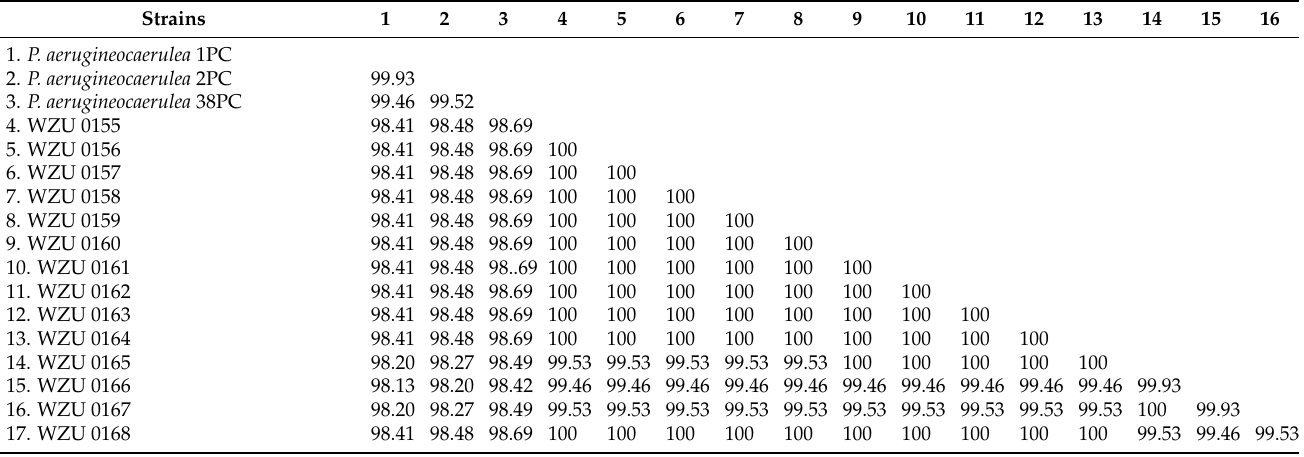
Table 5. Comparison of the 16S rRNA gene sequence similarity among all Potamolinea aerugineocaerulea